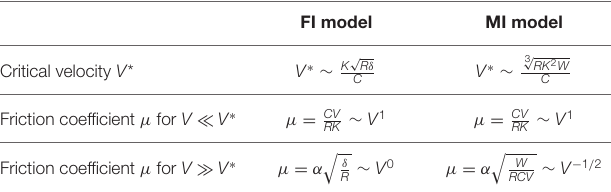
TABLE 2 | Velocity dependences of friction coefficient in steady sliding ( α 2 √ 2 / 3 =